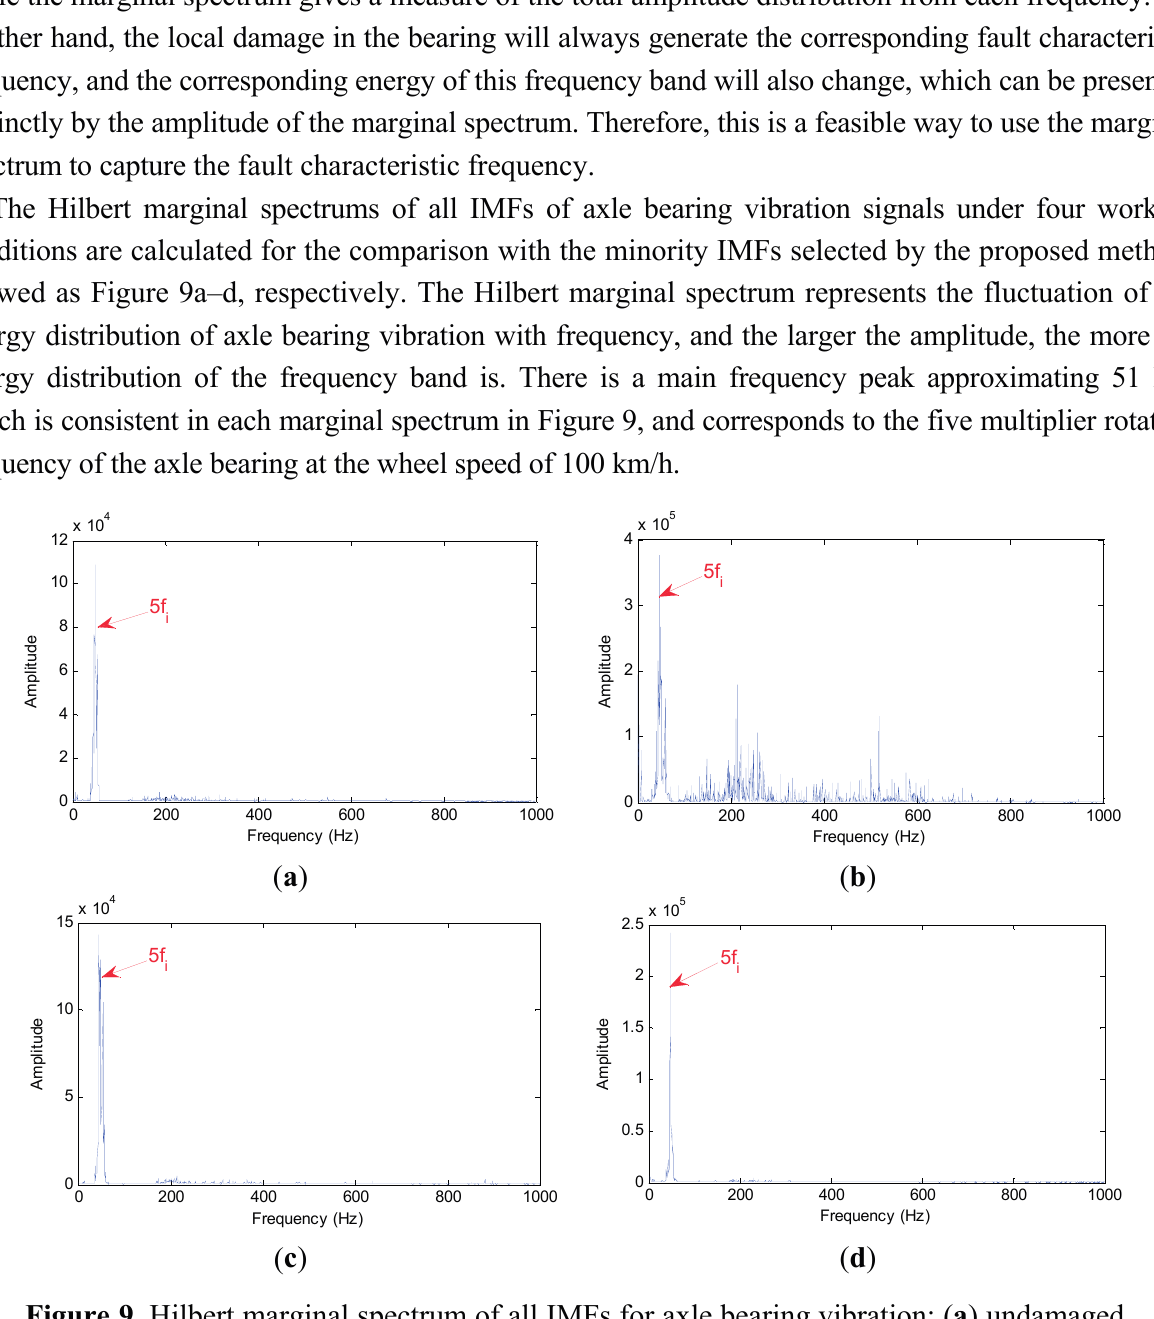
Figure 9. Hilbert marginal spectrum of all IMFs for axle bearing vibration: ( a ) undamaged bearing; ( b ) outer ring fault bearing; ( c ) cage fault bearing; ( d ) pin roller fault